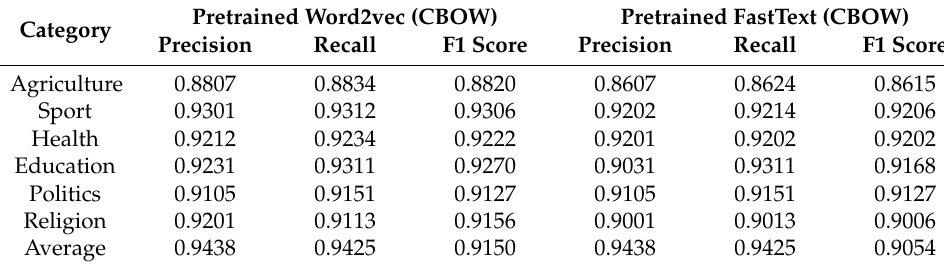
Table 8. Word2vec and FastText results by news